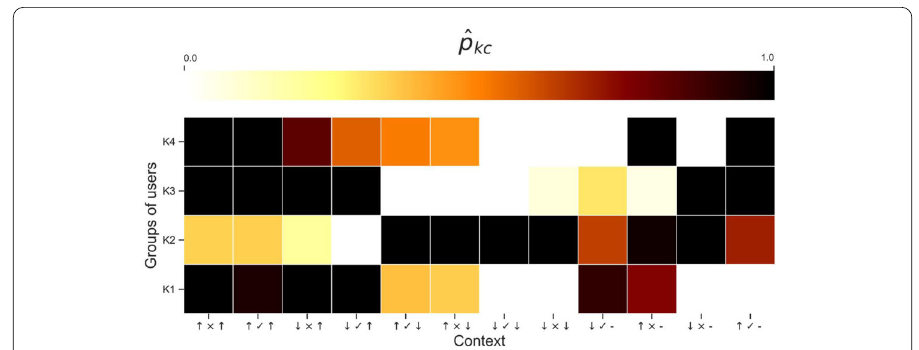
Figure 4 Inferred probability matrix for a group of users to guess ↑ . The symbols on the x -axis represent the context according to the following notation: market move ∈ {↑ , ↓} , outcome of previous guess ∈ { right (cid:2) , wrong ×} , expert’s guess ∈ {↑ , ↓ ,- } . We see the groups tend to describe well defined behaviors since the majority of matrix elements are either 1 or